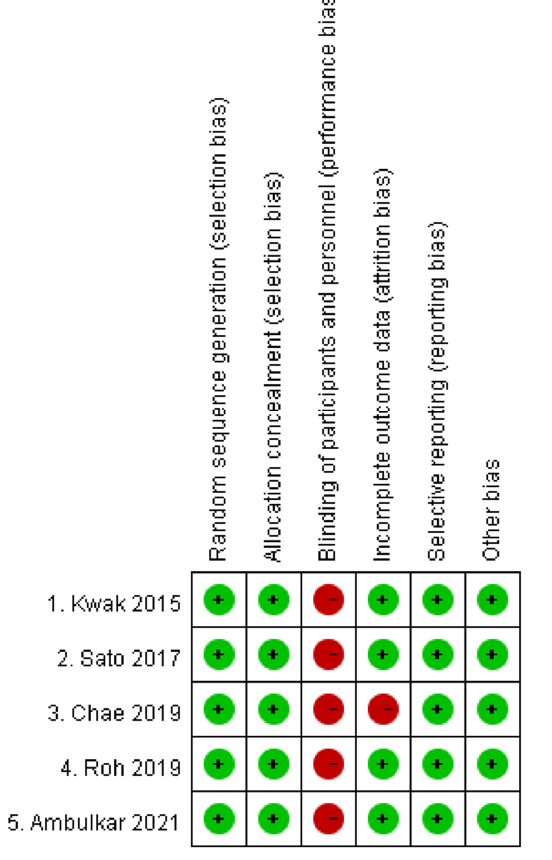
Figure 7. The summary of the risks of bias of the selected studies. Green circle with a plus symbol represents low risk of bias, and red circle with a minus symbol represents high risk of bias. All the studies face high risk of bias regarding the blinding of the participants.